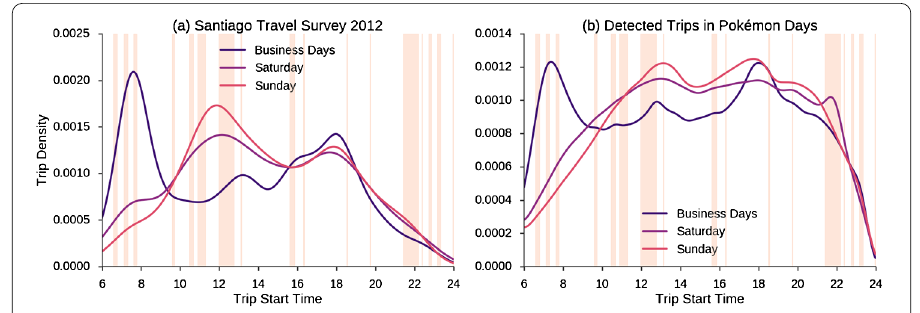
Figure 7 Distribution of trip start time according to: (a) the travel survey held in Santiago in 2012, and (b) detected trips during the Pokémon days. The trips are aggregated into business days, Saturdays, and Sundays. Each rectangle shows the time-window in which the Pokémon Go effect is significant in the regression